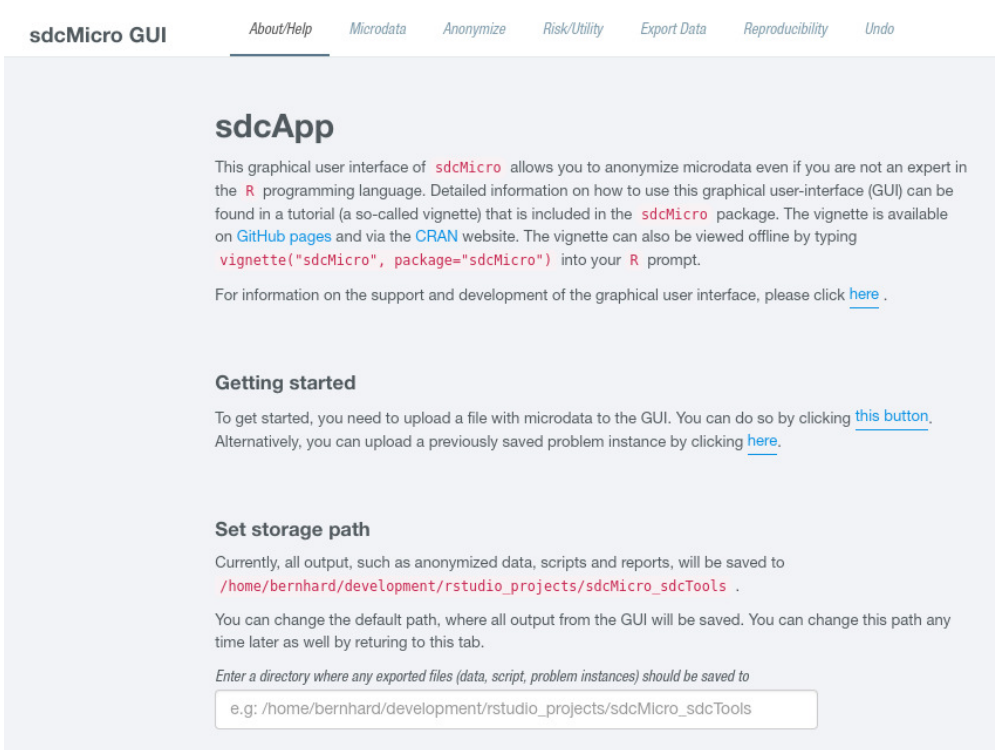
Figure 1. AboutHelp tab: Help-page of sdcApp after it has been